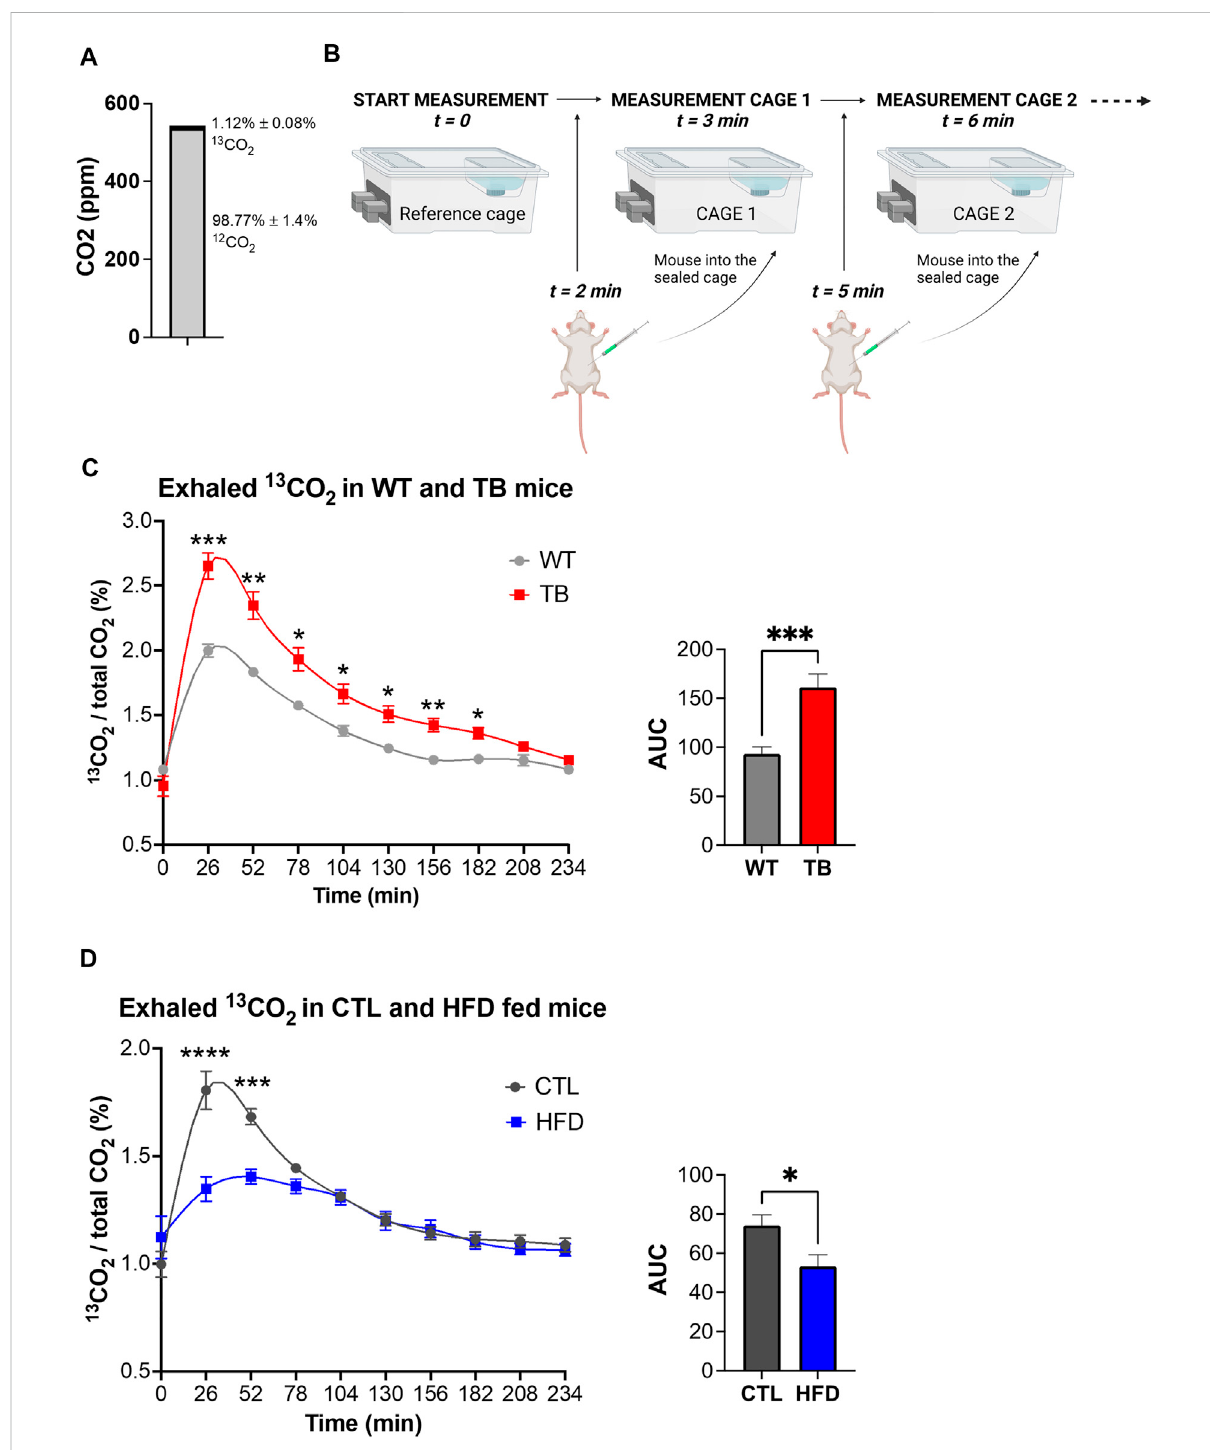
FIGURE 4 Glucose oxidation in two pathophysiological mouse models. (A) Environmental levels of 13 CO 2 and 12 CO 2 in the metabolic cages. (B) Experimental design depicting the reference cage and two of the experimental cages. (C) Measurements of exhaled 13 CO 2 normalized to total CO 2 and area under the curve (AUC) in WT and TB mice ( n = 10 mice per genotype). Data represent the mean ± SEM with p value cutoff indicated as * p < 0.05, ** p < 0.01, and *** p < 0.001 as determined by two-way ANOVA and Student ’ s t -test. (D) Measurements of exhaled 13 CO 2 normalized to total CO 2 and area under the curve (AUC) in CTL and HFD fed mice ( n = 6 mice per diet type). Data represent the mean ± SEM with p value cutoff indicated as * p < 0.05 and *** p < 0.001, and **** p < 0.0001 as determined by two-way ANOVA and Student ’ s t